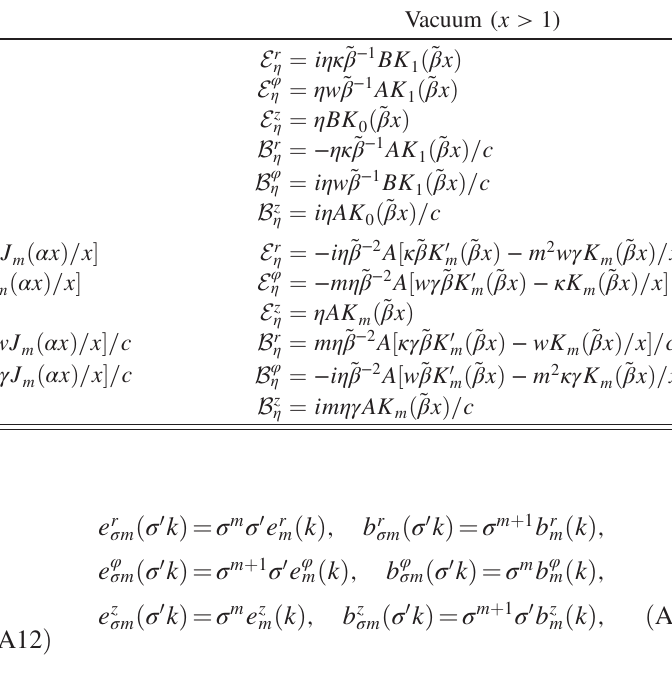
modes by B ¼ 0 . The HE n j m j n